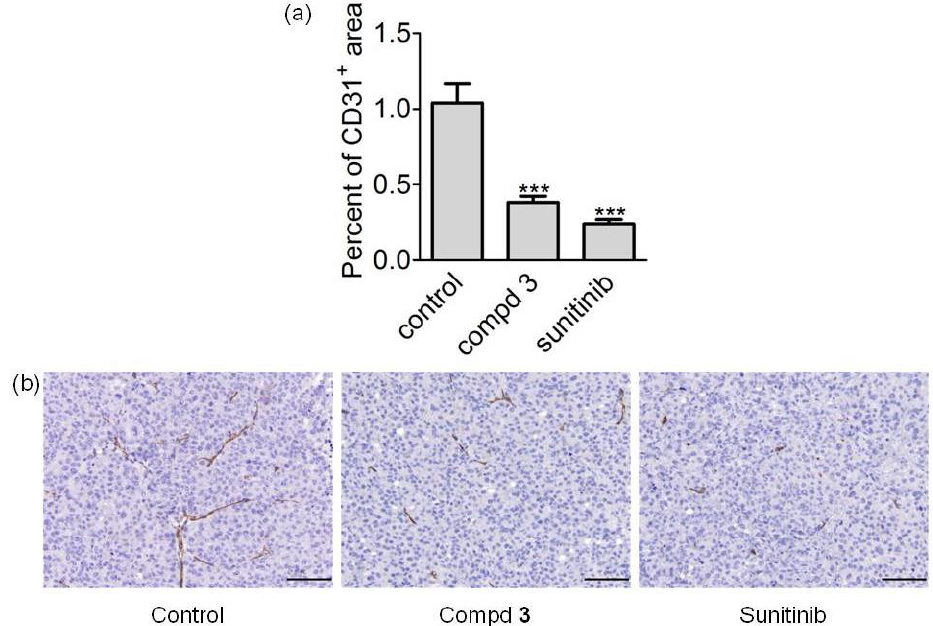
Figure 7. Evaluation of microvessels after treatment. Histopathological analysis of IGROV-1/Pt1 xenograft samples after treatment with compound 3 or sunitinib. ( a ) Quantitative analysis of tumor associated vasculature. CD31-positive area was measured in three randomly selected 200× microscopic fields from seven samples per group. The reported numbers correspond to the mean of CD31 positive areas in analyzed groups. Tumors were obtained from mice sacrificed 24 h after the last treatment; *** correspond to p < 0.001 by One Way ANOVA followed by Bonferroni Multiple Comparison test. ( b ) Representative 200× microscopic fields from a control group sample, and tumor from a sample treated with compound 3 and sunitinib. The scale bar corresponds to 100 μ m.